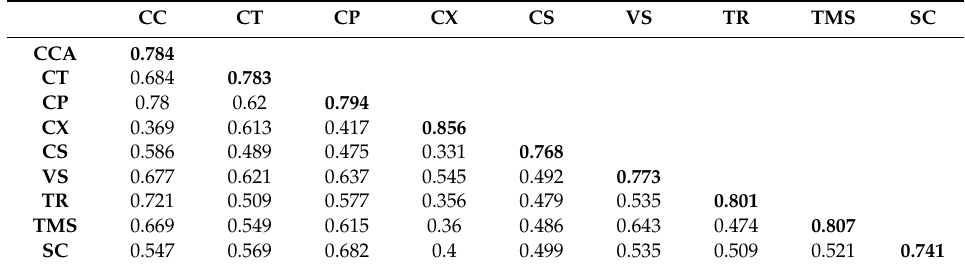
Table 6. Fornell–Larckers criterion analysis